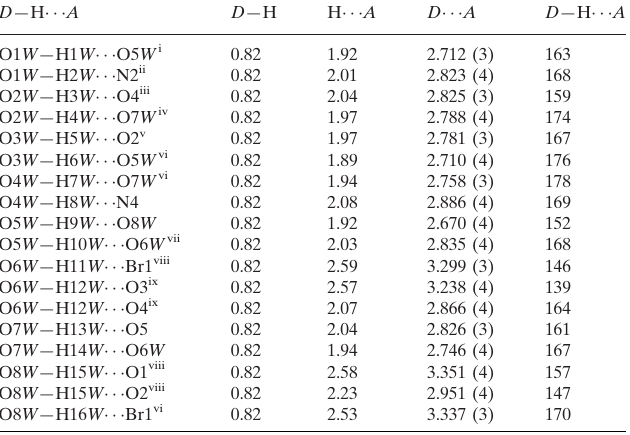
Data collection Bruker APEXII CCD O )(H O) ]- diffractometer 2 4 2 4 Absorption correction: multi-scan ( SADABS ; Sheldrick, 1996) T min = 0.232, T max = 0.324 Refinement 316 parameters Hydrogen-bond geometry (A˚ , (cid:3) ). D —H (cid:2)(cid:2)(cid:2) A D